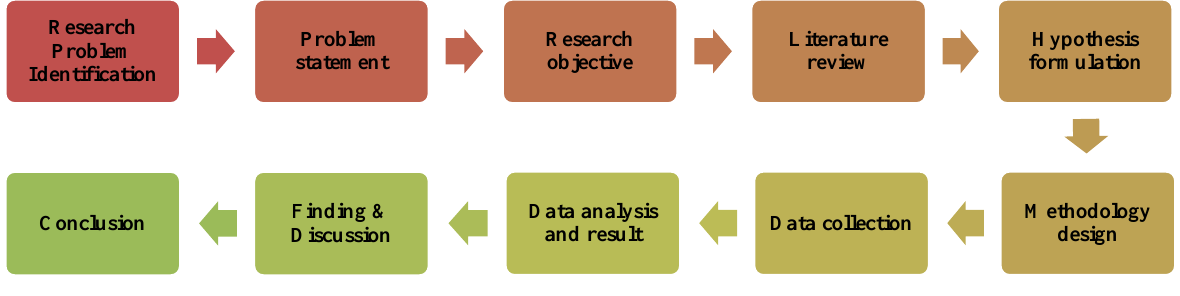
Figure 2. Flowchart of the research